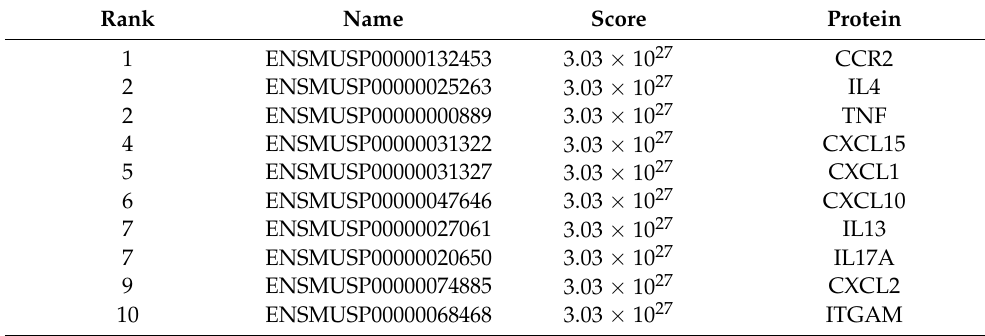
Table 3. MicroRNAs found in online databases with respective targets and scores (data last accessed in 10 April 2021). TargetScan 7.2 (https://www.targetscan.org/mmu_72/) relies on conservation of binding sites and divides miRNA families into broadly conserved (conserved across most vertebrates, usually to zebrafish), highly conserved (meaning that they are conserved across most mammals, but usually not beyond placenta) and poorly conserved (all others) [24]. miRDB (http://mirdb.org/) prediction scores are between 50 and 100, assigned by new computational target prediction algorithms (>80 considered most likely to be real) [19]. miRmap (http://mirmap.ezlab.org), ranks potential tar-